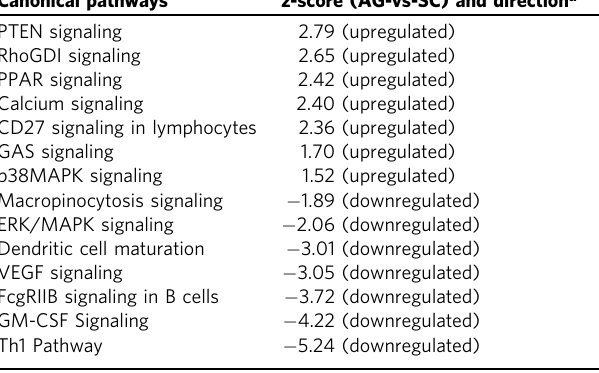
a z-score is a measure of signi fi cance for the directionality of a biological function/pathway derived from the gene expression pattern. A positive z-score indicates activation/upregulation, and a negative z-score indicates suppression/downregulation of a biological